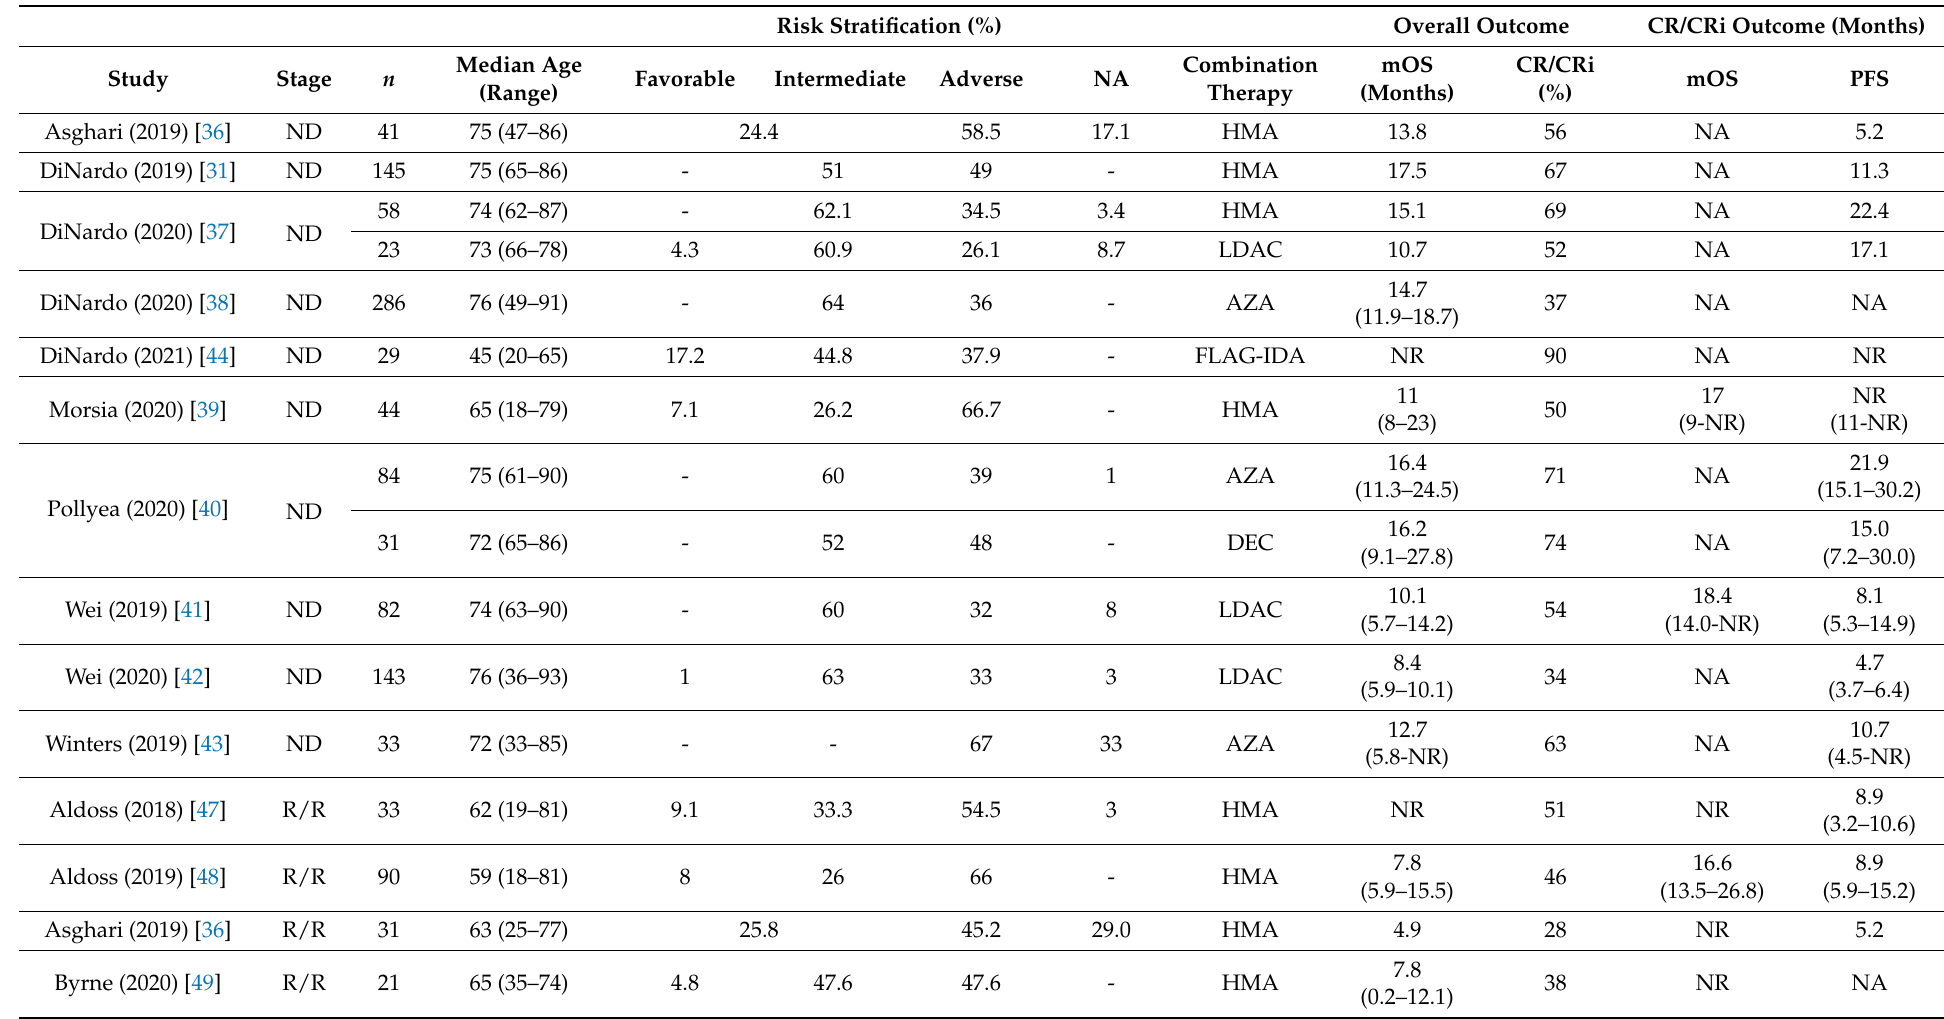
Table 1. Overview of studies with venetoclax-based therapy for AML patients. Risk Stratification (%) Overall